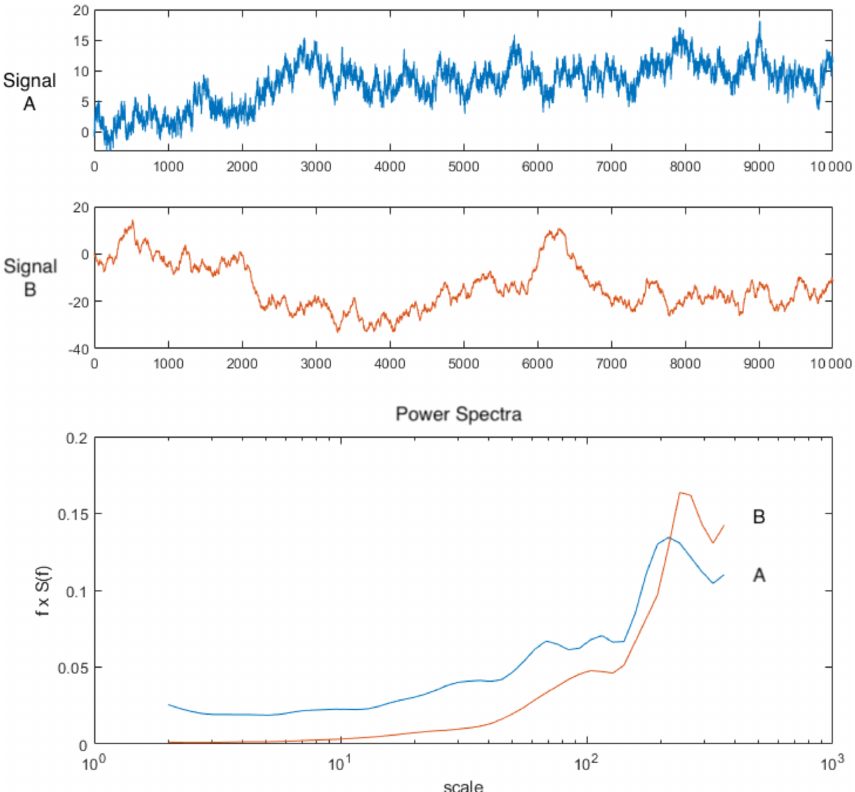
Figure A1. Sample signals with relatively higher noise (signal A) and lower noise (signal B) and their corresponding power spectra ensemble plotted as normalized on log scale. Note the representation of the variance by area under the curve is preserved by multiplying the power ( S(f ) ) by the frequency ( f ). In this way the area beneath the curve is still proportional to the variance.